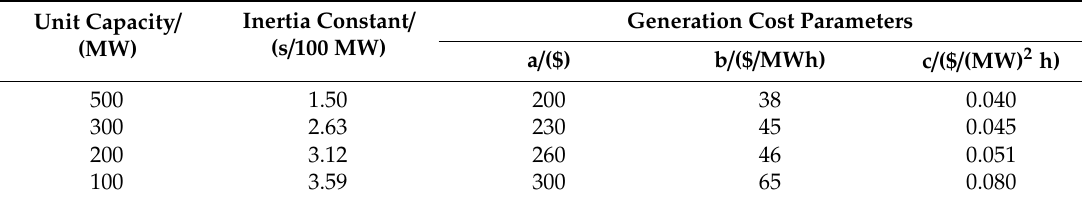
Table 2. Parameters of each kind of thermal generation unit.